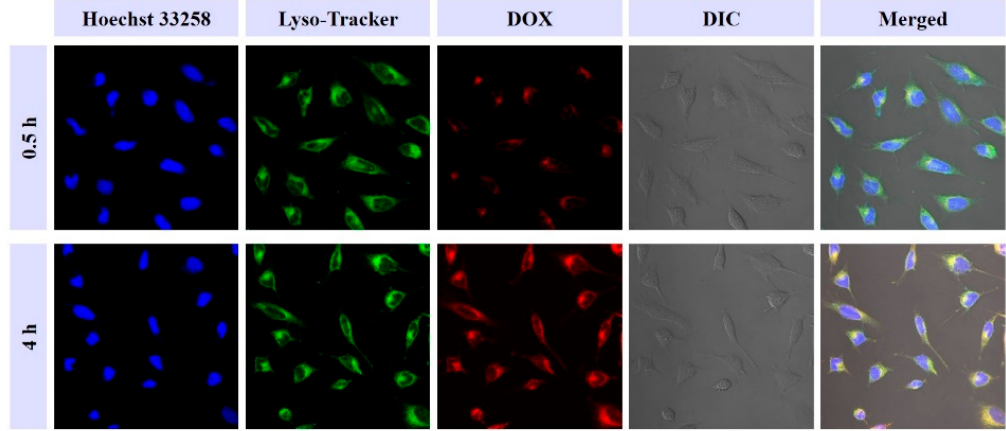
Figure 7. Cellular uptake of oDex-g-Pt+DOX NPs (platinum plus DOX conjugated oxidized dextran nanoparticles) was determined by confocal laser scanning microscopy.